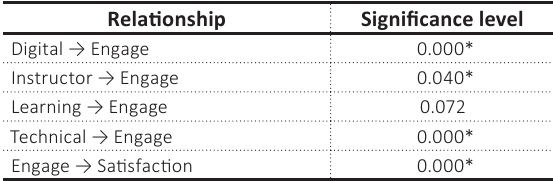
Table 8. Relationship in the